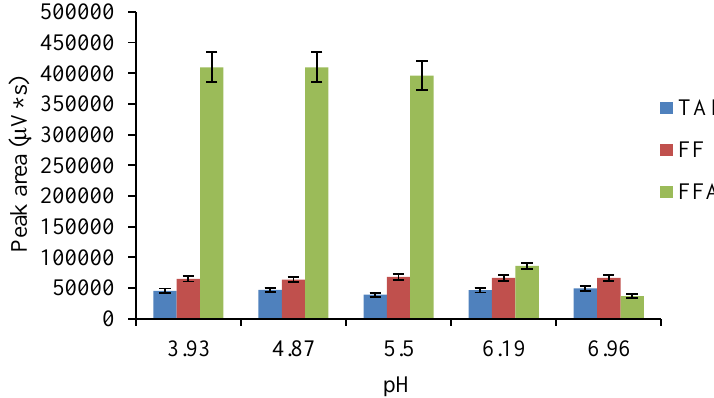
Figure 2. E ff ects of pH on the target Figure 2. Effects of pH on the target responses.